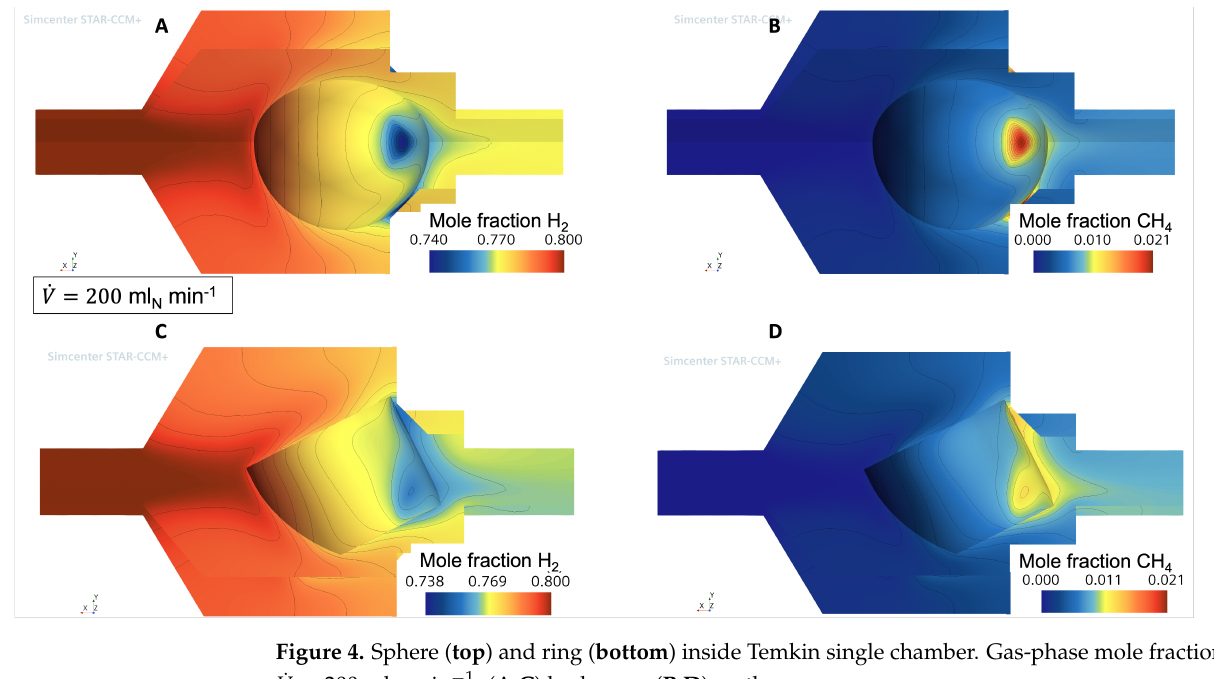
Figure 4. Sphere ( top ) and ring ( bottom ) inside Temkin single chamber. Gas-phase mole fractions at